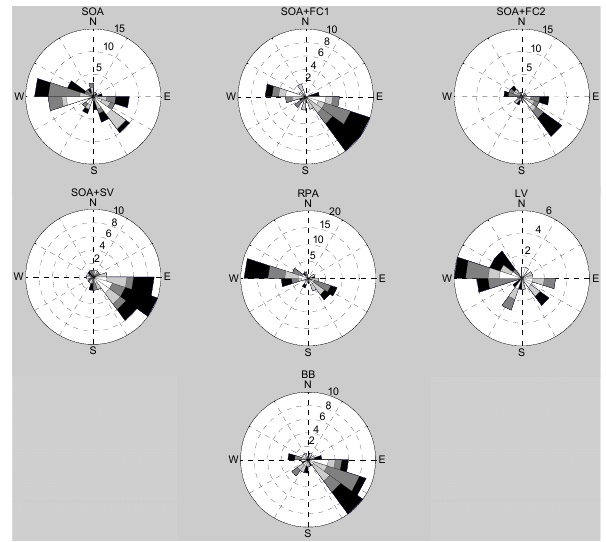
Fig. 13. Rose plots of the 7 fall PMF factors using only factor concentrations > 1 standard deviation of mean factor concentrations to emphasize dominant source directions. Frequency of observations are represented by the length of each wedge, and labeled by concentric rings. The shade of each wedge represents source concentrations in quartiles (dark = higher concentrations).